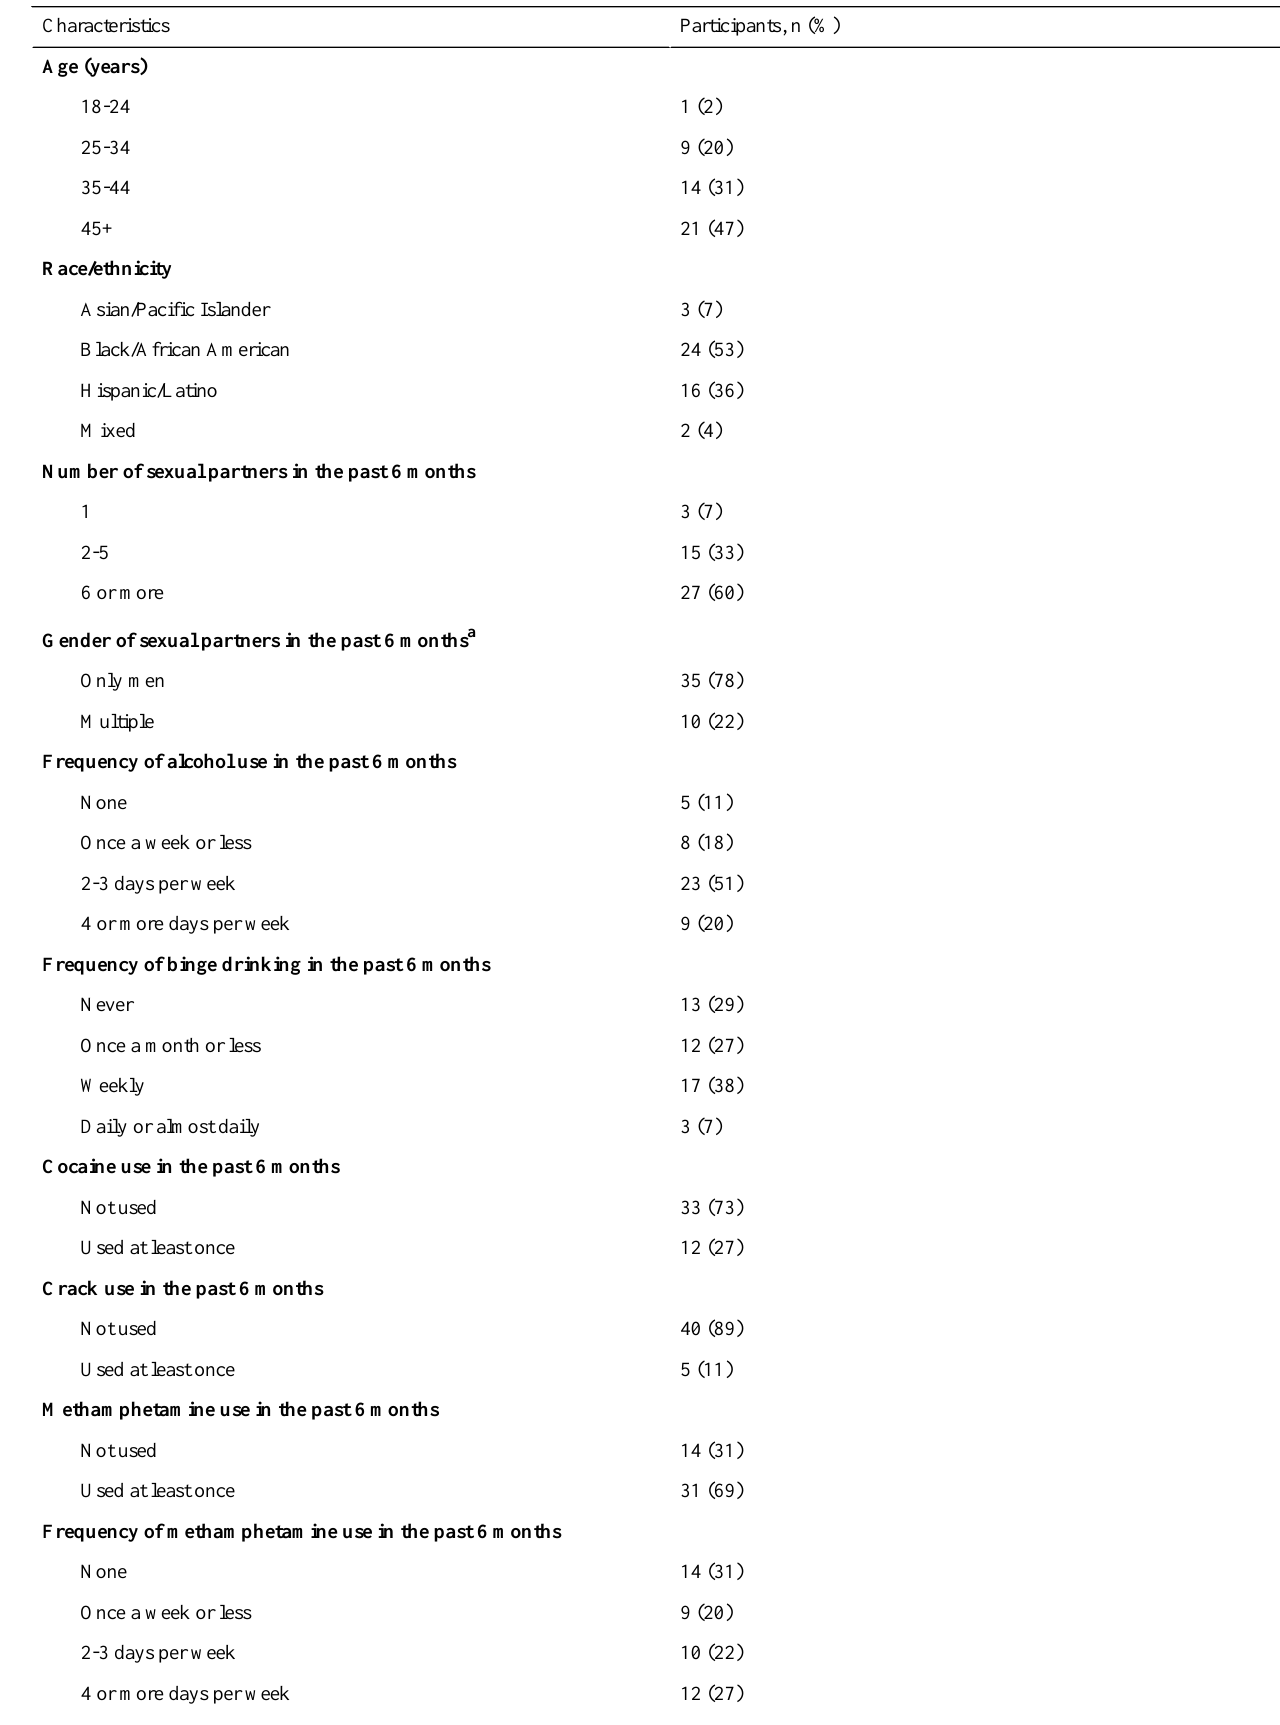
Table 1. Participant demographics, sexual behaviors, and substance use behaviors collected at baseline